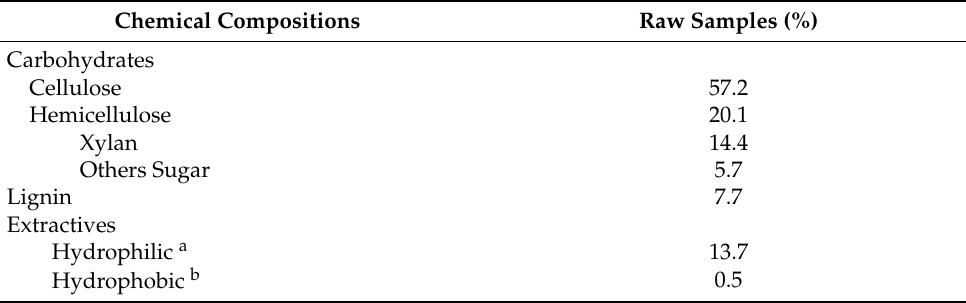
Table 1. Materials’ balance of raw kenaf outer